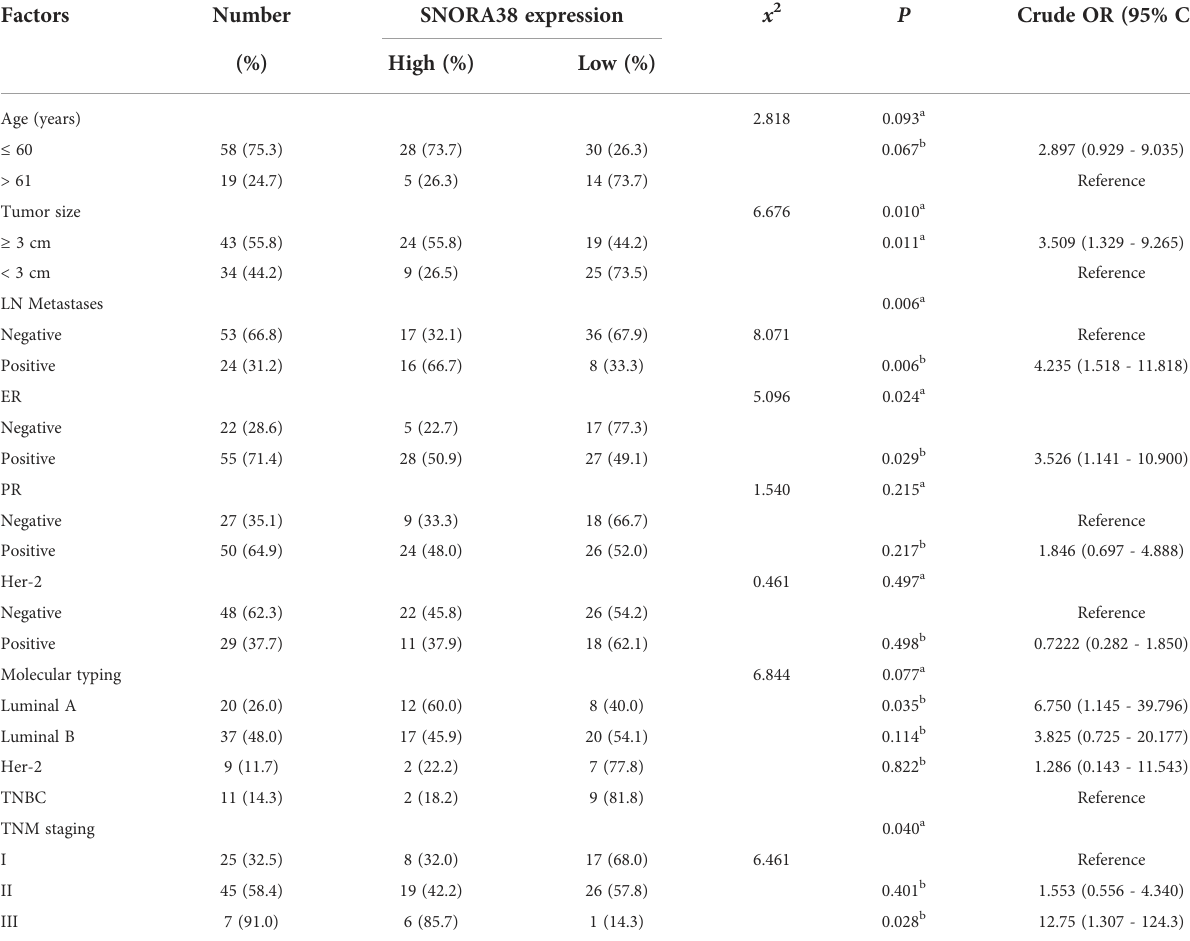
TABLE 1 Univariate analysis of SNORA38 expression and clinical pathology